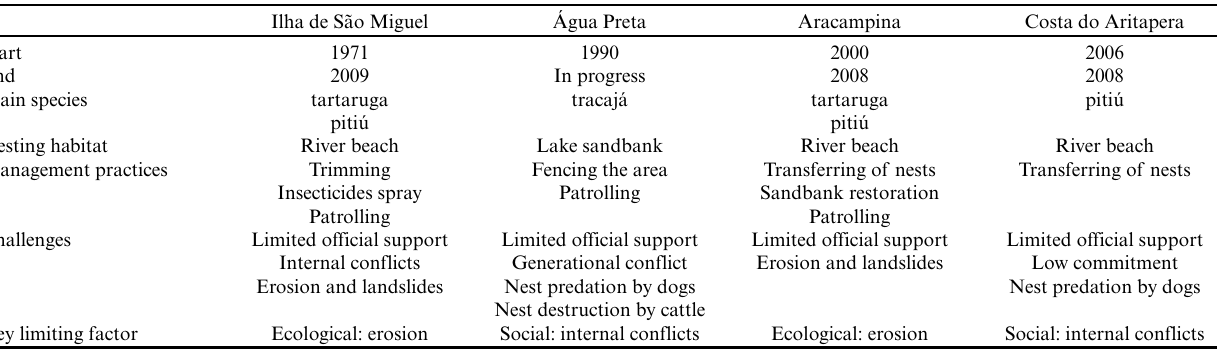
Table 2 . Characteristics of the turtle management initiatives carried out by four communities in the lower Amazon